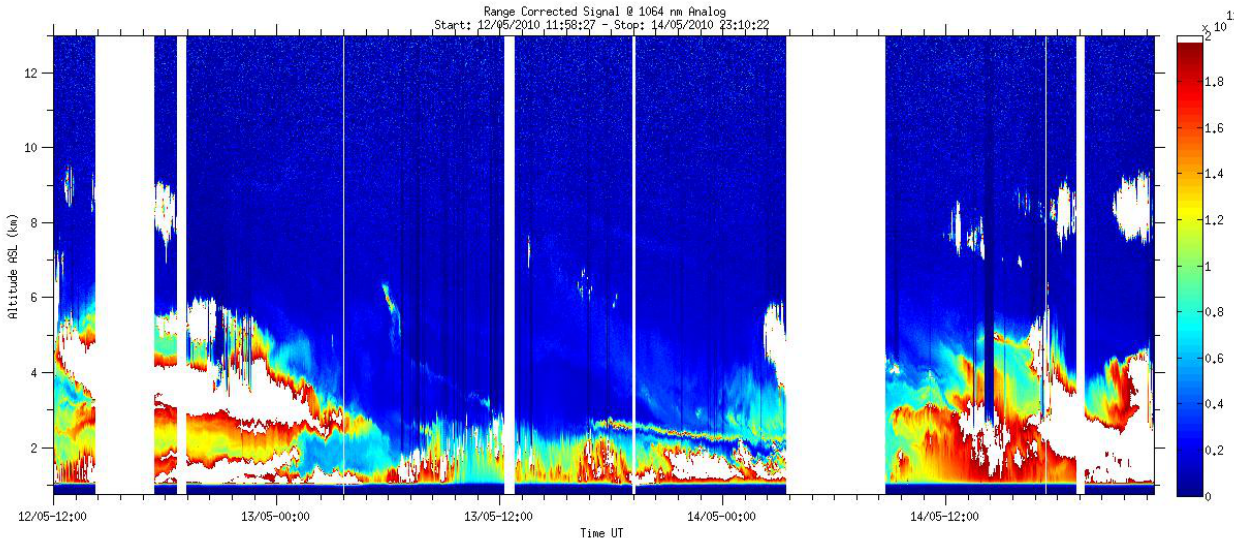
Fig. 1. Temporal evolution of the range corrected lidar signal measured at 1064nm in the period 12–14 May by PEARL at CIAO. The vertical and temporal resolutions are 7.5 m and 30 s,